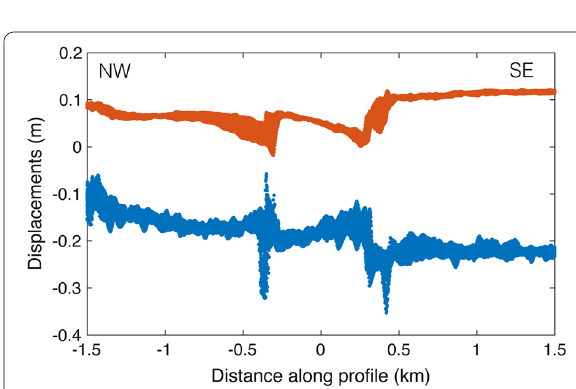
Fig. 5 Profiles of vertical (red) and horizontal (blue, right-lateral) displacements across the faults, created from the data in the boxes shown in Fig. 4. The vertical displacements were given an arbitrary offset in the vertical axis for